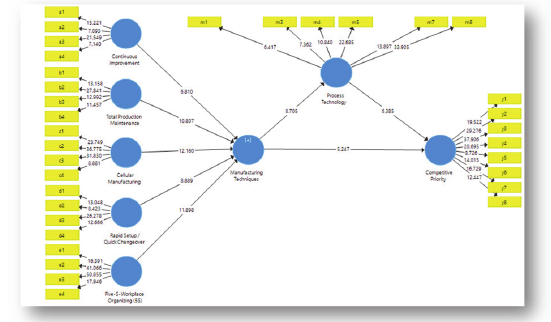
Fig. 3. The results of Standardized Loading and Path Coefficients for the Trimmed Model Significance Using T Test Results for the